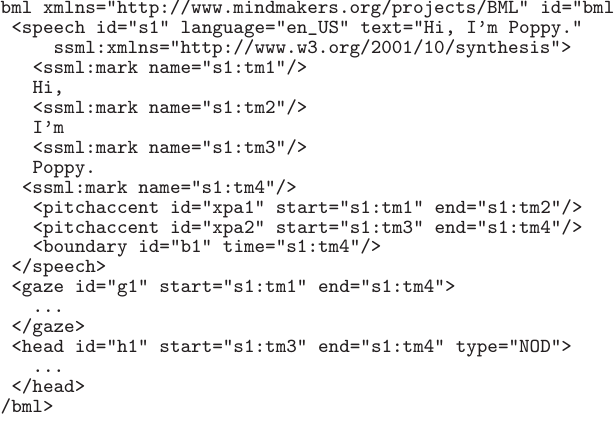
Figure 9: An example BML document containing SSML and gestural markup.